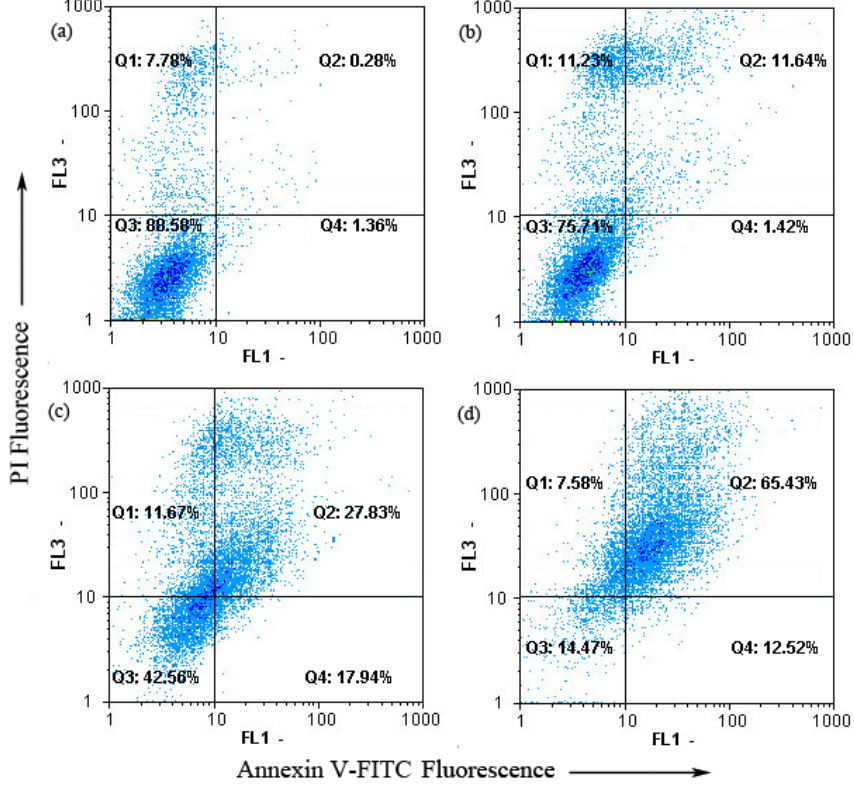
Figure 3. Chamaejasmine induced apoptosis in MDA-MB-231 cells using annexin V-FITC/PI. ( a ) Treatment with 0 μ M chamaejasmine; ( b ) treatment with 4 μ M chamaejasmine;